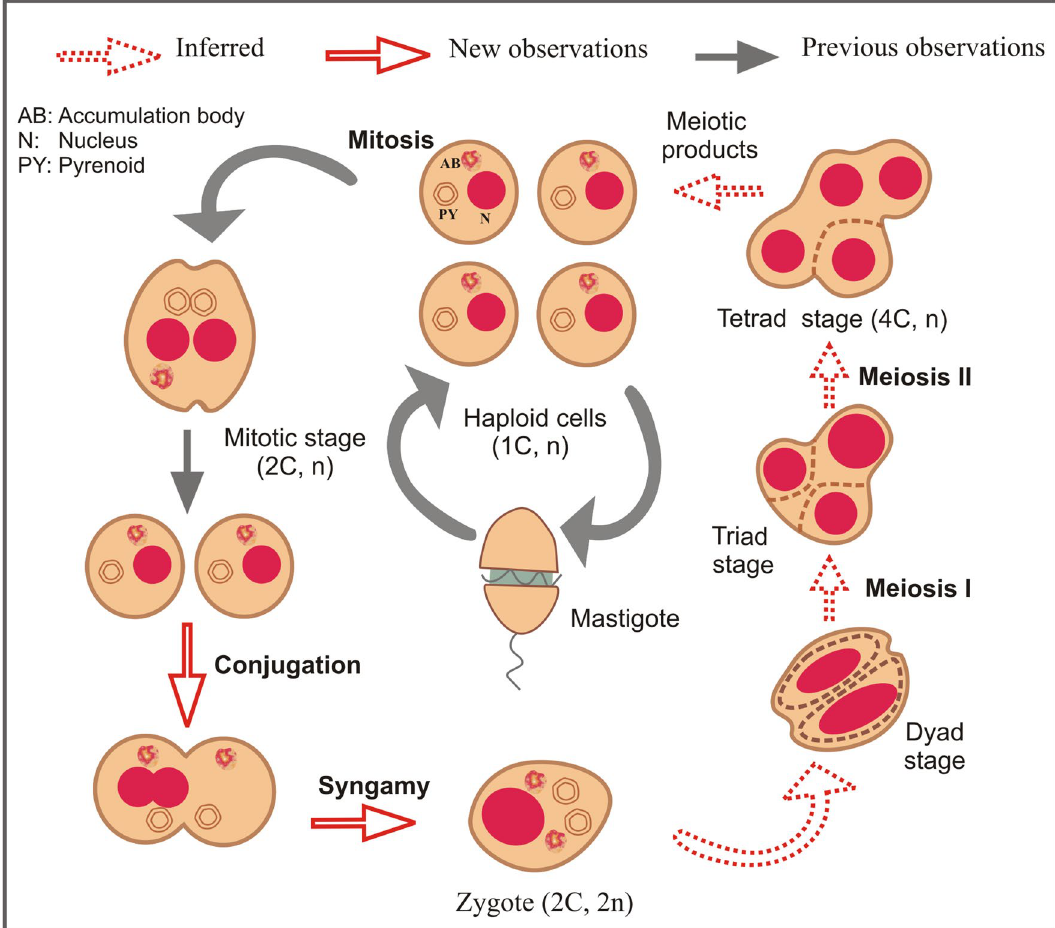
Figure 11. Updated proposed life cycle hypothesis for Symbiodiniaceae, based on the findings of this study. Vegetative cells are characterized by the presence of three unique elements: nucleus (N), pyrenoid (PY) and accumulation body (AB). Mitotic cells replicate their DNA, forming a larger (2C) nucleus. Nuclear division (karyokinesis) occurs first, followed by cytoplasmic division (cytokinesis). Pyrenoids are observed to duplicate in advanced cytokinesis stages, when the outer cellular morphology is already indicative of two cells. Zygotes (2 N, diploid) have a larger nucleus than vegetative cells due to the nuclear fusion of gametes. Two pyrenoids and accumulation bodies are present after fusion as a result of the cytoplasmic contribution of each gamete. DNA replicates once, giving rise to a 4C DNA content cell, which then divides into two cells (dyad) during meiosis I. Asynchronous division during meiosis II leads to the formation of triads and eventually to a 4-cell stage (tetrad) of haploid, 1C DNA content